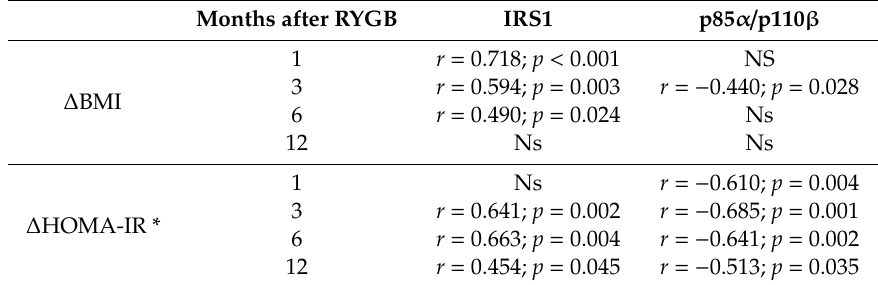
Table 5. Significant associations found between baseline expression levels of the studied genes and the evolution of body mass index (BMI) and insulin resistance (HOMA-IR) after RYGB. Months after RYGB IRS1 p85 α / p110